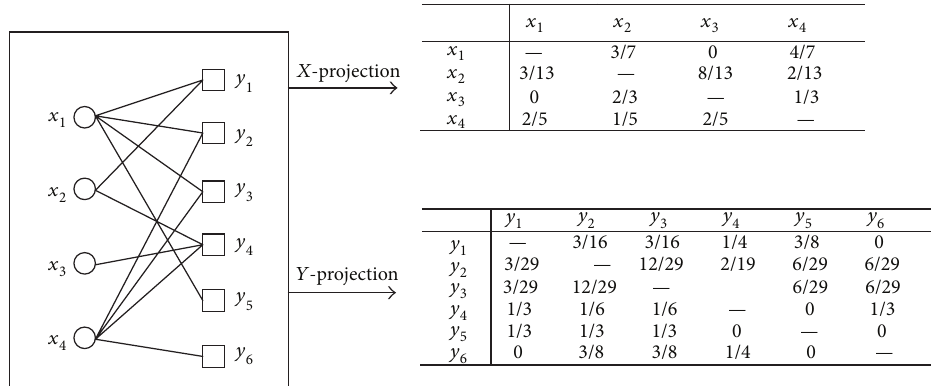
Figure 1: An example of calculating vertex correlations. The left-hand figure is the structure of a bipartite network and the right-hand one shows correlation